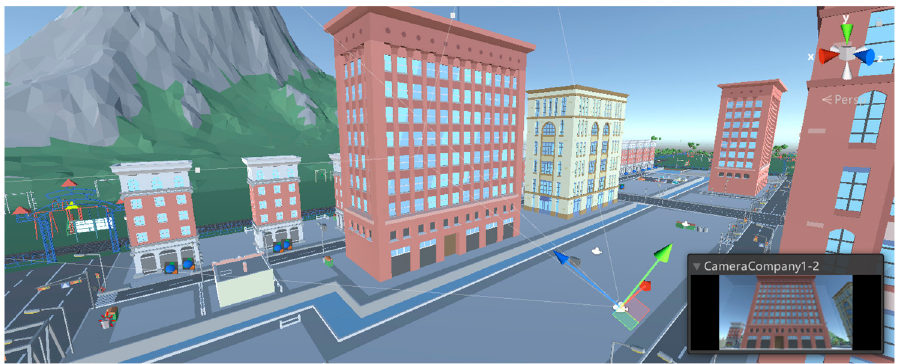
Figure 5. Realization of taking photos.